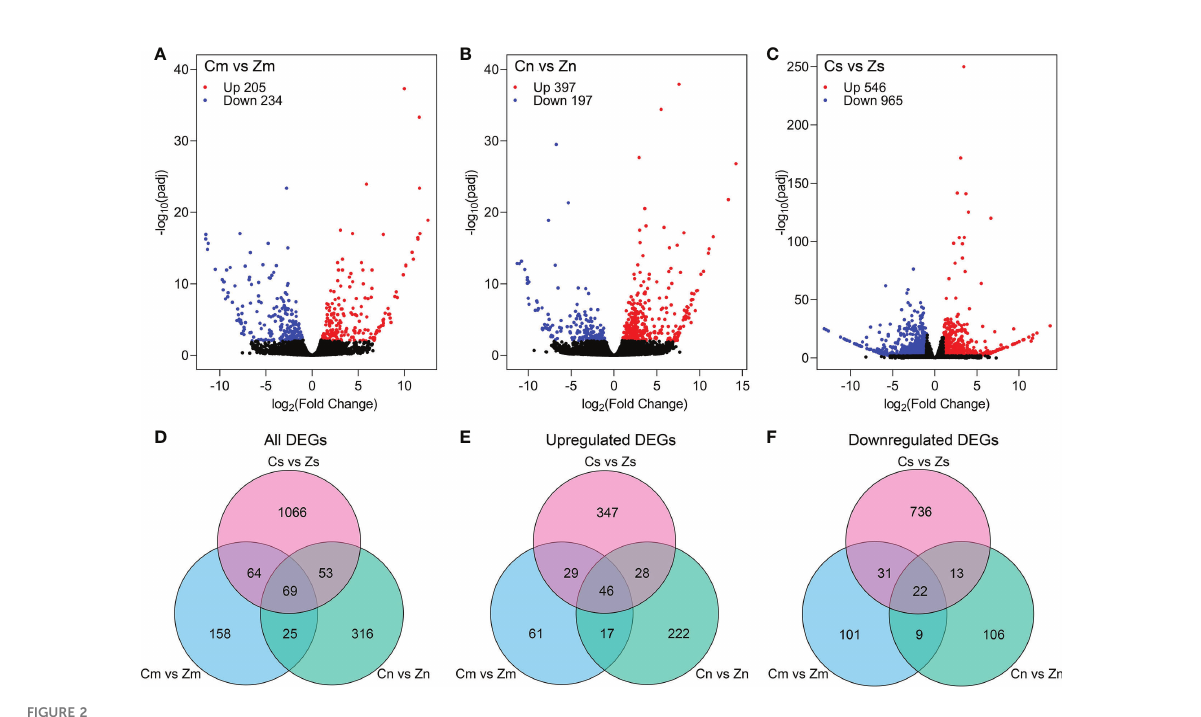
FIGURE 2 Identi fi cation of differentially expressed genes (DEGs) in torpedo-stage embryo and endosperm, and early seeds between C and Z. (A – C) Volcano plots showing DEGs in the embryo (A) , endosperm (B) , and seeds (C) between C and Z. (D – F) All (D) , upregulated (E) , and downregulated (F) DEGs in the embryo, endosperm, and seeds